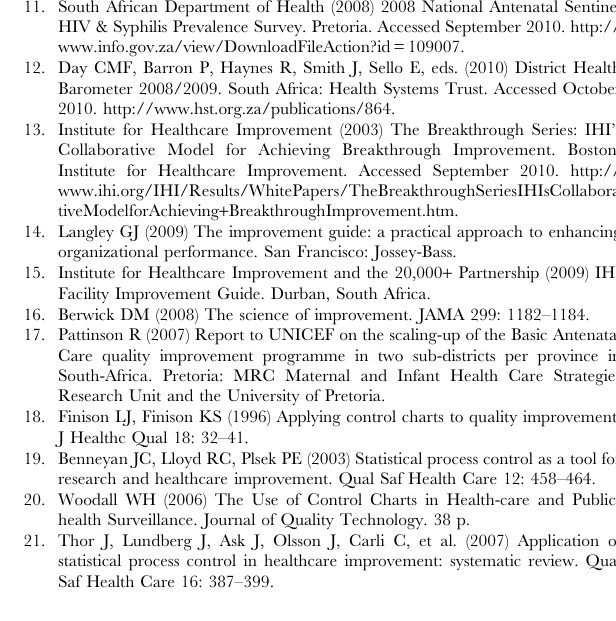
Figure S1 Labour Ward Checklist. Checklist tool that was developed to improve performance of PMTCT care processes in labour